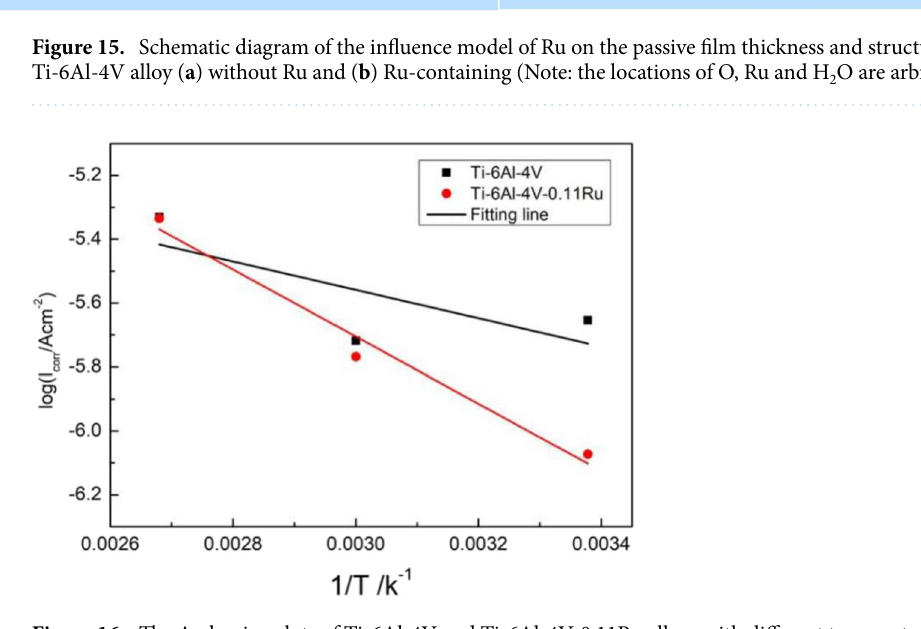
Figure 16. The Arrhenius plots of Ti-6Al-4V and Ti-6Al-4V-0.11Ru alloys with different